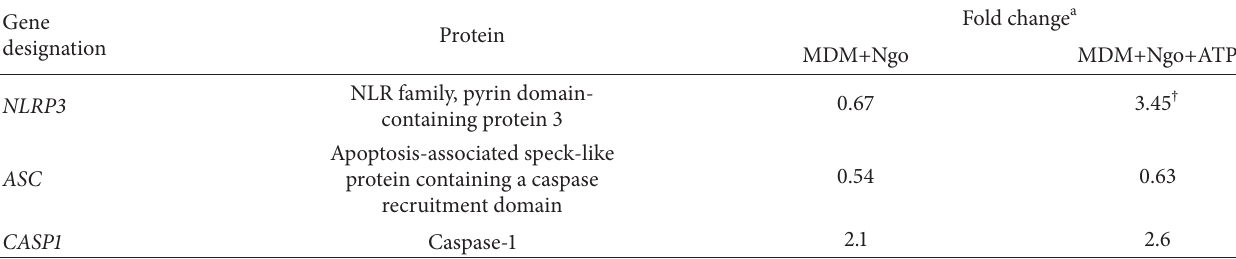
Table 1: Transcriptional activation of inflammasome-associated genes in MDM.